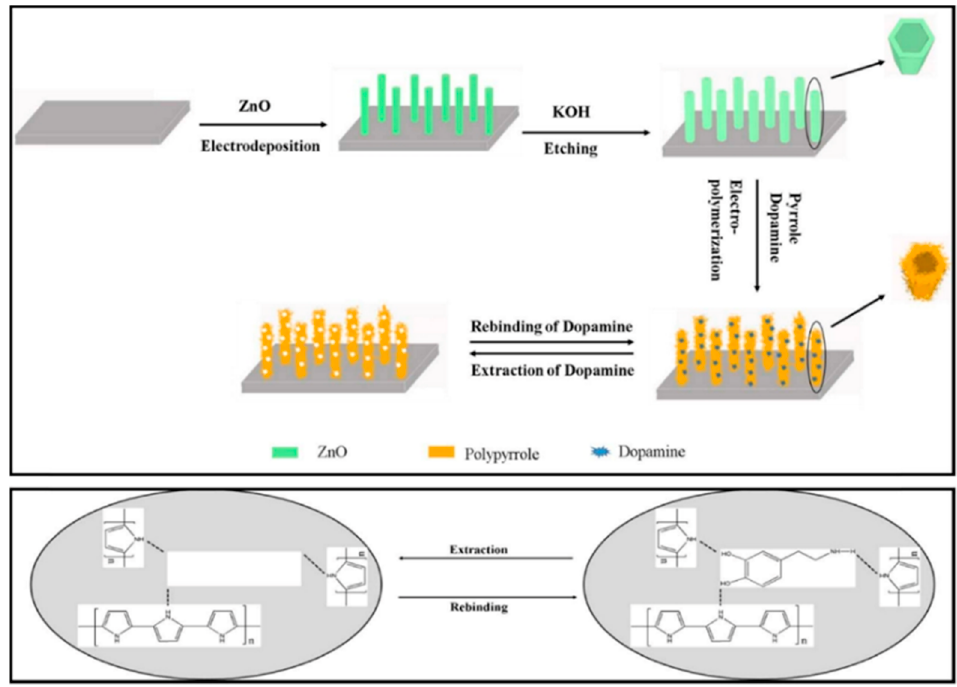
Figure 1. Schematic representation of the molecularly imprinted polymers fabrication process of composite MIPs/ZNTs/FTO glass and its interaction with dopamine. Reproduced with permission from [90]. Copyright 2017 Elsevier B.V.